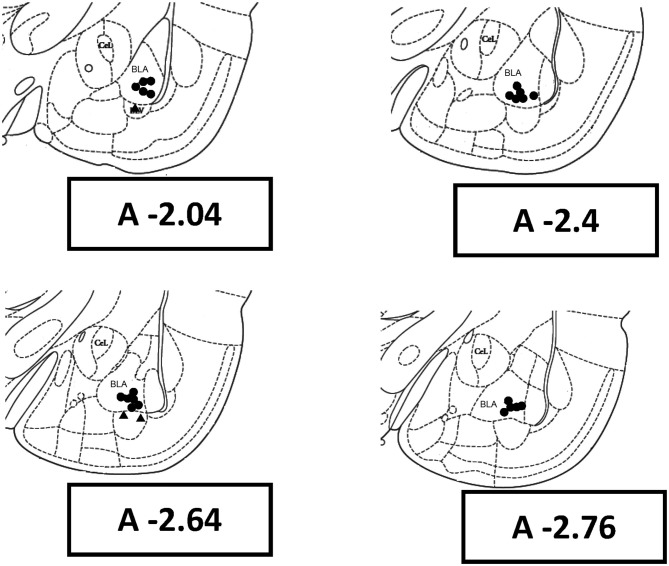
Rat brain coronal sections with reference to the bregma show histological reconstruction of the stimulation sites in kindle animals. BLA, basolateral amygdaloid nucleus, anterior; CeL, centrolateral nucleus.